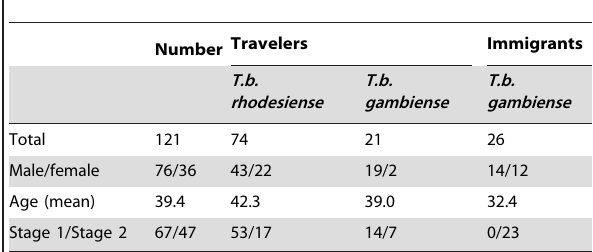
Table 1. Description of the